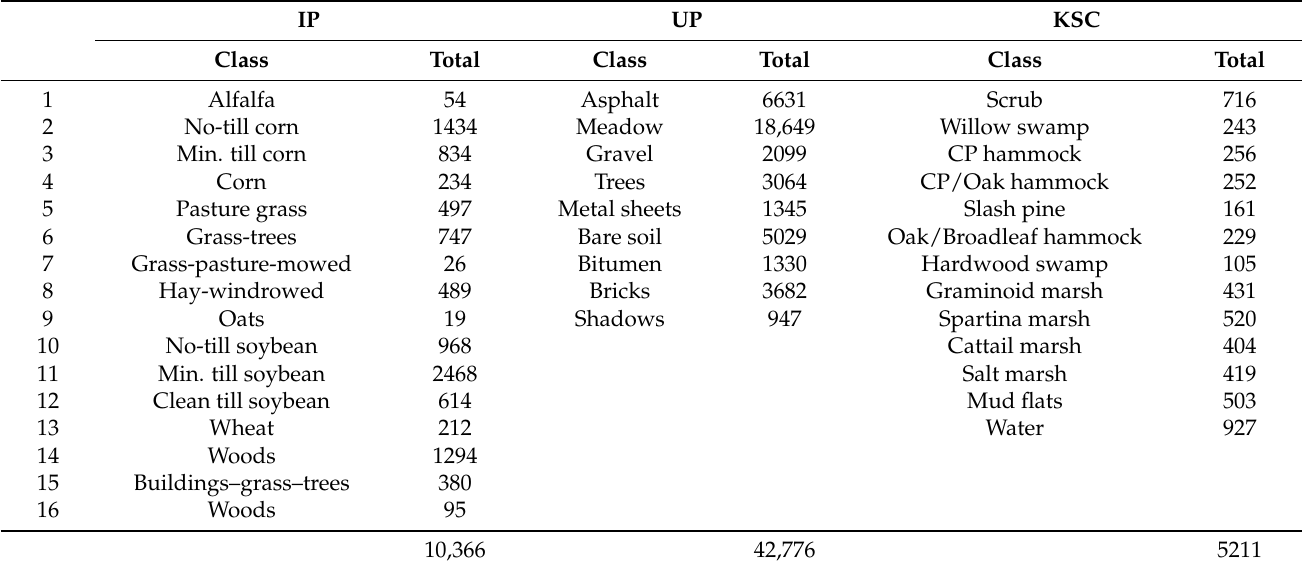
Table 2. The samples for each category of IP, UP, and